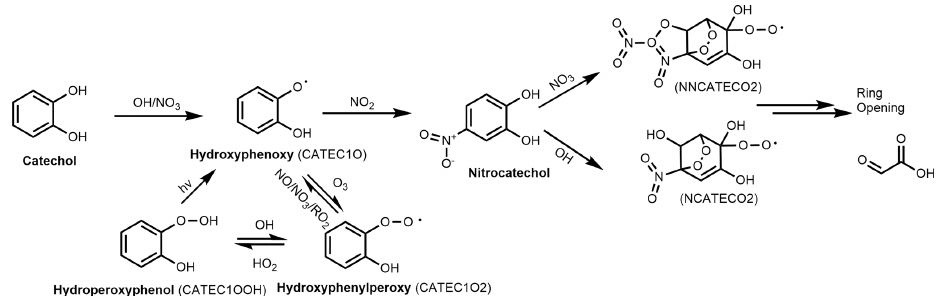
Figure 7. Schematic depiction of the atmospheric formation and loss of nitrocatechol in the gas phase based on the reaction pathways included in the Master Chemical Mechanism (MCMv3.3.1). Species names used in the MCM are given in parentheses.